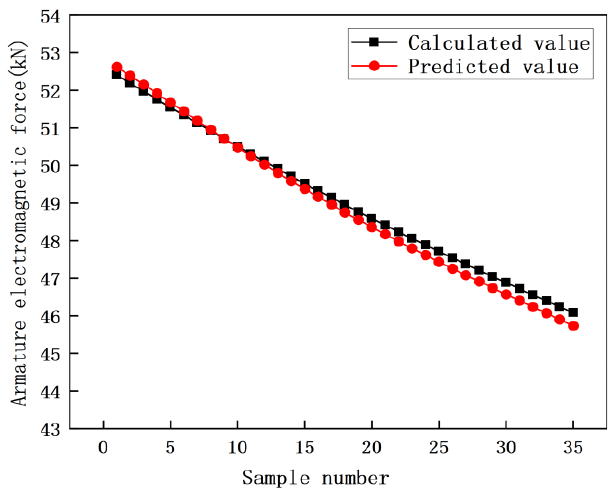
Figure 12. Comparison between the calculated value and the predicted value of armature electro- magnetic force.